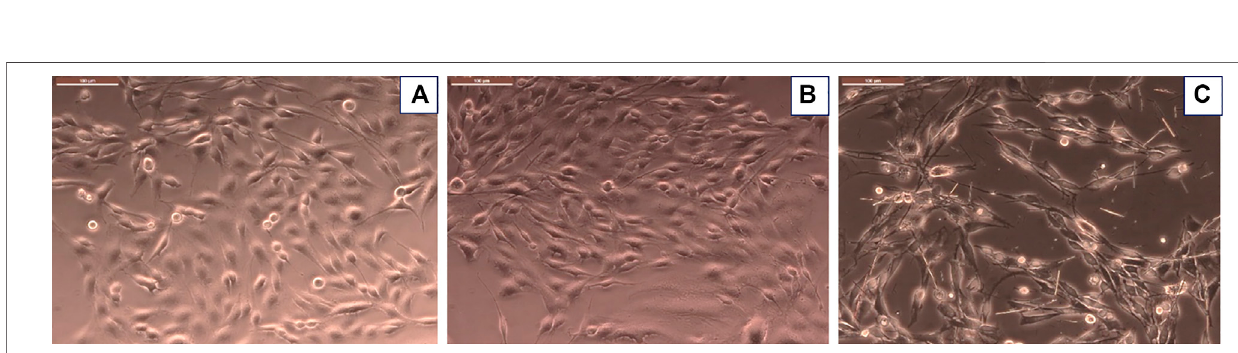
FIGURE 4| CRL2303glioma cells response to 20 μ g/ml CuHARS treatment in presence ofin fl ammatory stimulations (100 ng/ml ofTNF+ 5 μ g/ml of LPS). (A) NO concentration in the cells due to the treatment showing signi fi cant difference in NO release from CRL2303 cells treated with CuHARS compared to cells treated with in fl ammatory stimulus alone. The negativecontrols treated with LNAME (LN), a NOS inhibitor, showed signi fi cant inhibition in NO release. (B) Cell metabolism due to the treatment showing inhibition of cell metabolism for CuHARS treated glioma cells including in the presence of in fl ammatory stimuli (as in Panel A). Data represent average of three experiments ( N (cid:2) 3) with triplicated wells ( n (cid:2) 3). The error bars represent SEM values, “ *** ” represents p < 0.001, and “ * ” represents p < 0.05.